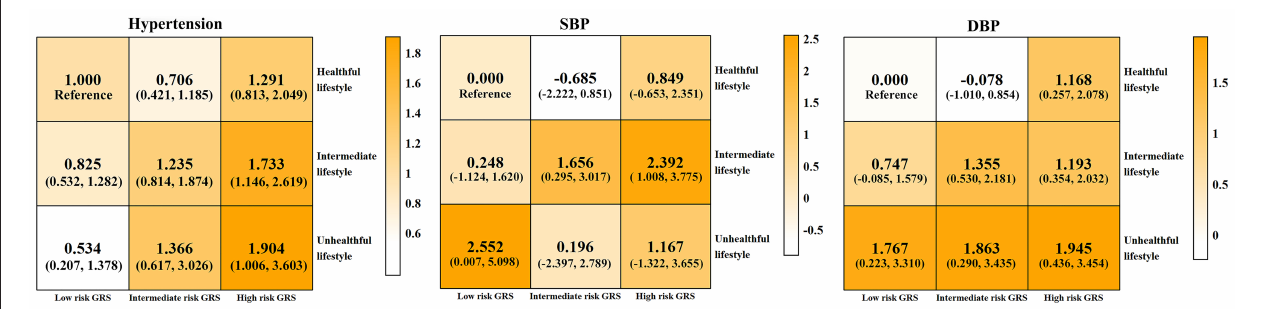
FIGURE 2 | Combined effect of genetic and lifestyle on hypertension, SBP, and DBP. Low, intermediate, and high GRS risk were tertile 1, tertile 2, and tertile 3 of GRS, respectively; unhealthful, intermediate, and healthful lifestyle group were composed of LS for 0 and 1, LS for 2 and 3, and LS for 4 and 5, respectively. Hypertension, SBP level, and DBP level were the outcomes at the 3-year follow-up. Logistic regression was used to analyze the association of lifestyle and GRS with outcomes because of the short follow-up period. Take the participants with low risk of GSR and healthful lifestyle as the reference. The data in each square represent the effect size of each outcome [odds ratio (95% CI) for hypertension, β (95% CI) for SBP and DBP]. Covariates: age, sex, antihypertensive medicine, family history of hypertension, educational level, marriage, income, baseline SBP, and baseline DBP. The color bars on the right correspond to different effect values. No significant additive interaction effect of GRS and lifestyle score was observed (95% CI of RERI included 0). DBP, diastolic blood pressure; GRS, genetic risk score; SBP, systolic blood pressure.